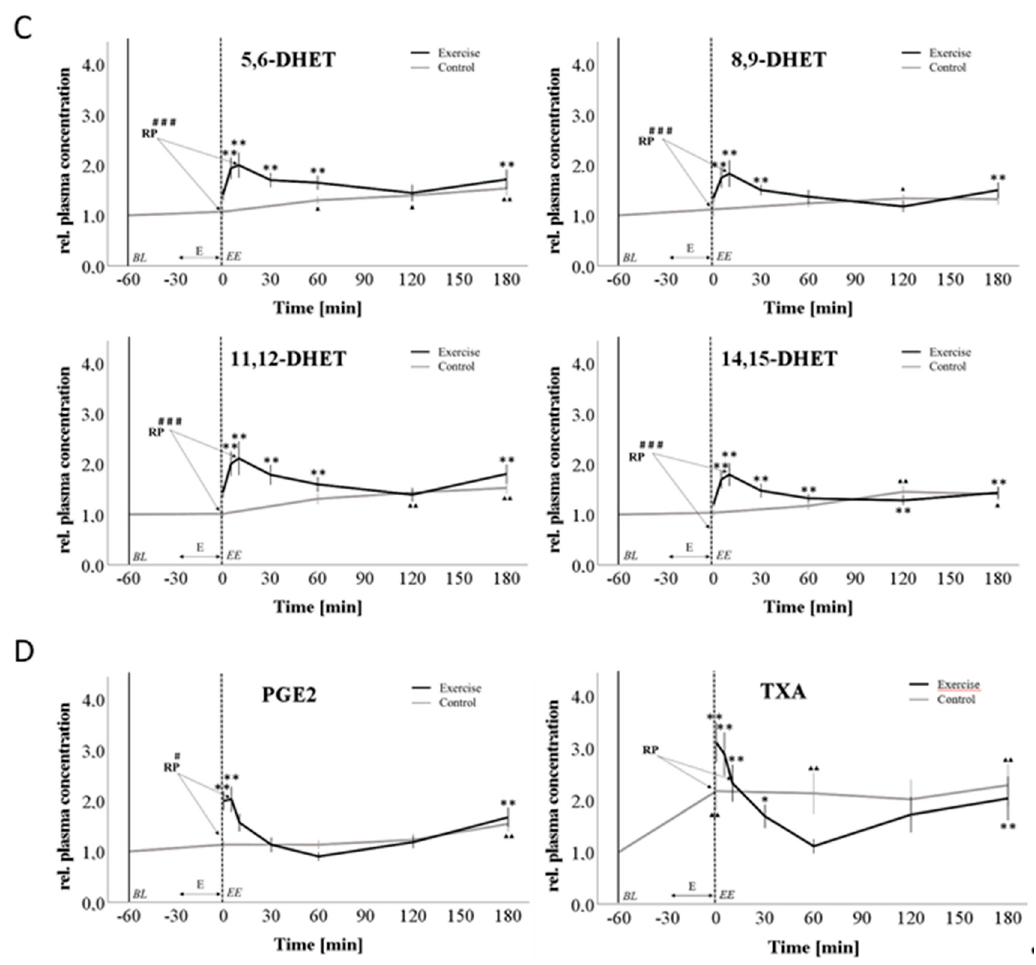
Figure 4. Time courses of the relative levels of arachidonic acid ( A ) and its metabolites (( B ) HETEs, ( C ) DHETs and ( D ) prostaglandins) in plasma. Baseline (BL) values were determined at − 60 min at both study days and were set as 1 for better comparison. Exercise (E) was performed between − 30 min and 0 min. Since it was not possible to perform measurements during ergometer cycling, there is a gap in the exercise intervention graph during this period. black: exercise intervention grey: sedentary control intervention; values are expressed as mean fold change from baseline